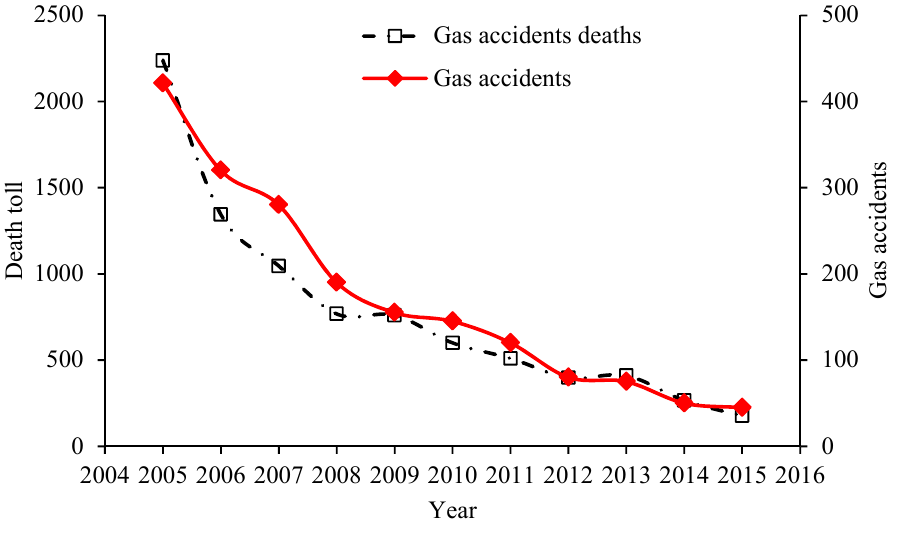
Figure 1. Gas accident statistics from 2005 to 2015 in China.